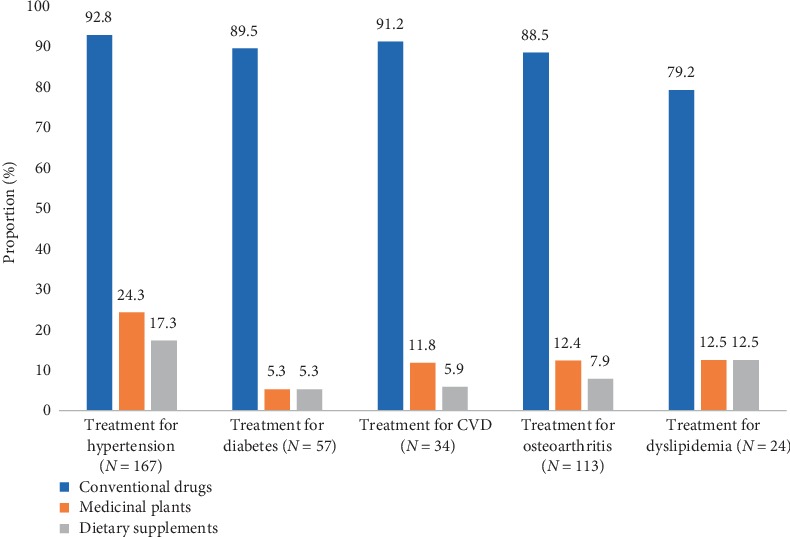
Types of medications used according to medical conditions. CVD: Other cardiovascular diseases.